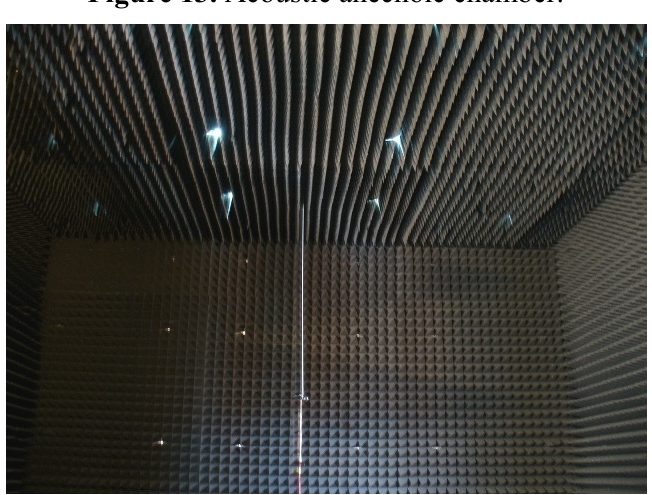
Figure 13. Acoustic anechoic